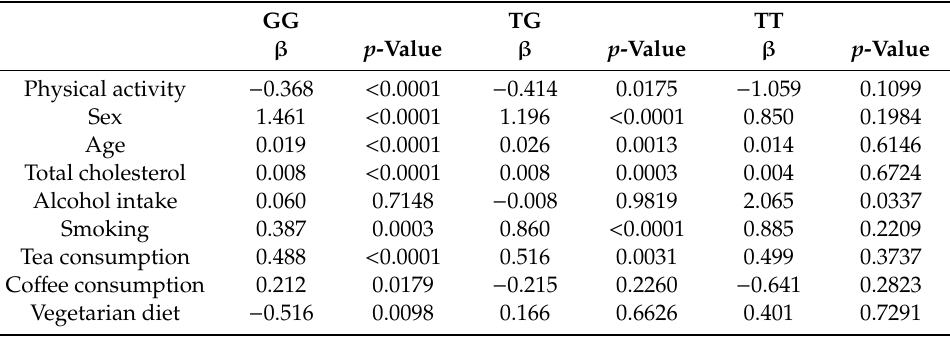
Table 4. Association of analyzed variables with BMI in groups with di ff erent genotypes.